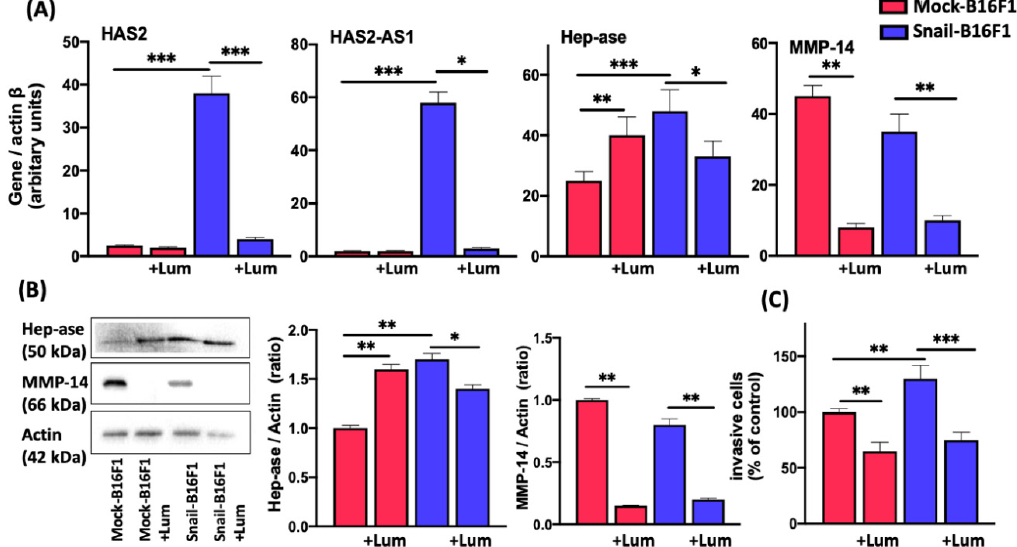
Figure 5. Lumican’s effects on hyaluronan biosynthesis players, matrix-degrading components and cell invasion. ( A ) qPCR analysis of the HA biosynthesis markers HAS-2 and HAS2-AS1 and of Heparanase and MMP-14. HAS2 gene expression is very low in Mock-B16F1 in absence or in presence of lumican. In contrast, HAS2 gene expression is high in Snail-B16F1 cells. Lumican significantly attenuates the gene expression of HAS-2 (40 times) in Snail-B16F1 melanoma cells. The HAS2-AS1 gene expression is very low in Mock-B16F1 in the absence or presence of lumican. In contrast, HAS2-AS1 gene expression is high in Snail-B16F1 cells. HAS2-AS1 was drastically decreased in Snail-B16F1 cells (from 58 to 0.5) in presence of lumican. Heparanase gene expression in Mock-B16F1 is significantly stimulated in presence of lumican. In addition, Heparanase gene expression is high in Snail-B16F1 cells as compared to Mock-B16F1 cells but is decreased by lumican treatment. MMP-14 gene expression is high in Mock-B16F1 and in Snail-B16F1 cells but it is significantly decreased in presence of lumican in both cell types. ( B ) Protein expression of heparanase and MMP-14 in Mock-B16F1 and Snail-B16F1 melanoma cells incubated 48 h with lumican (100 nM) analyzed by western immunoblotting and normalized to actin. The protein expression of heparanase and MMP-14 varies in a similar manner to that of their gene expression. ( C ) The effect of lumican in cell invasion was evaluated following cell cultures for 48 h in the absence and presence of lumican using type I collagen as substrate. Untreated Mock-B16F1 cells (control) exhibited significantly lower invasion potential than Snail-B16F1 cells. Lumican significantly decreased the invasion of both cell lines, with more profound effect in Snail-B16F1 cells. Each bar represents the mean of three independent experiments analyzed in triplicate. Asterisks indicate statistically significant differences (*, p < 0.05; **, p < 0.01; ***, p < 0.001).